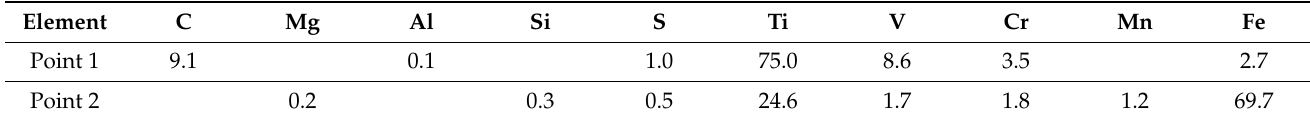
Table 9. Element percentage (wt.%) measured at positions in Figure